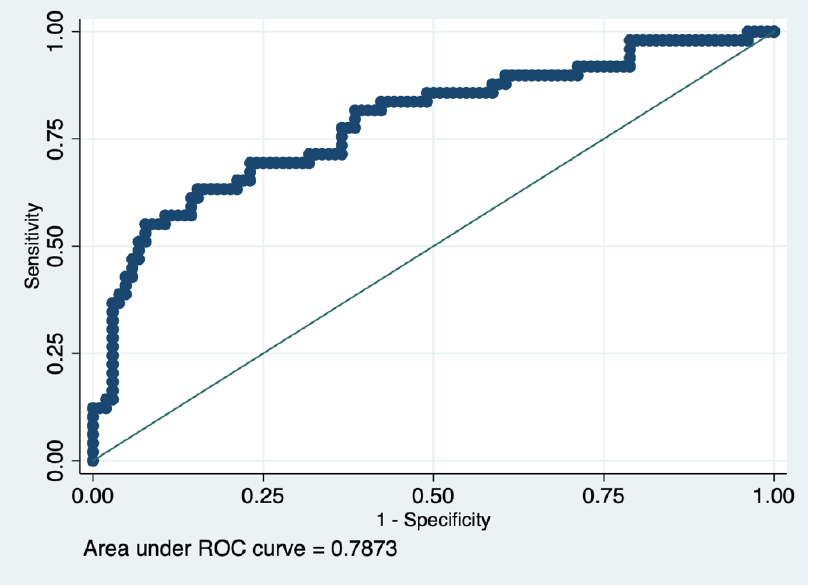
Figure 1. Area under the receiver operating characteristic (ROC) curve of the logistic model.